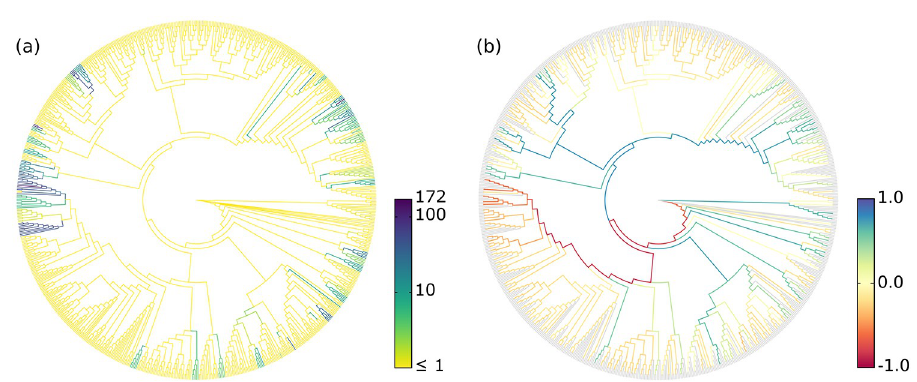
Fig 4. Examples of Edge Dispersion and Edge Correlation. We applied our novel visualization methods to the BV dataset to compare them to the existing examinations of the data. (a) Edge Dispersion, measured as the standard deviation of the edge masses across samples, logarithmically scaled. (b) Edge Correlation, in form of Spearman’s Rank Correlation Coefficient between the edge imbalances and the Nugent score, which is a clinical standard for the diagnosis of Bacterial Vaginosis. Tip edges are gray, because they do not have a meaningful imbalance. This example also shows the characteristics of edge masses and edge imbalances: The former highlights individual edges, the latter paths to